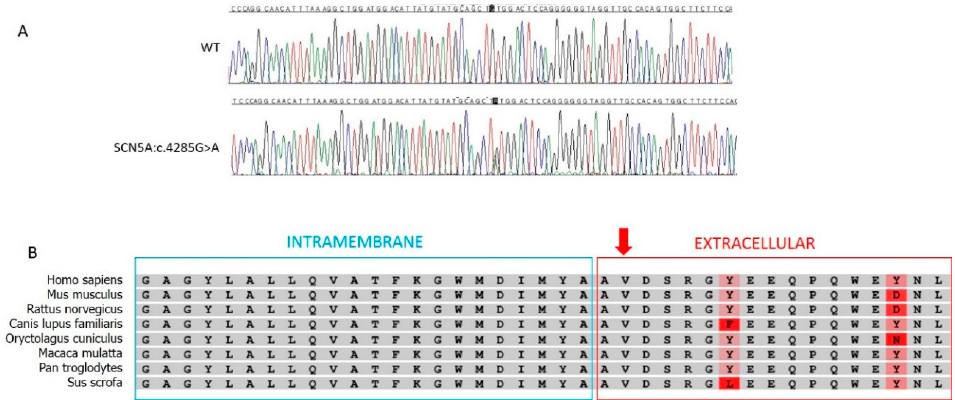
Figure 3. A. Identification of the novel heterozygous variant c.4285G>A in the SCN5A gene by Sanger sequencing. B. Interspecies conservation of the p.Val1429 residue, denoted by the red arrow (Uniprot